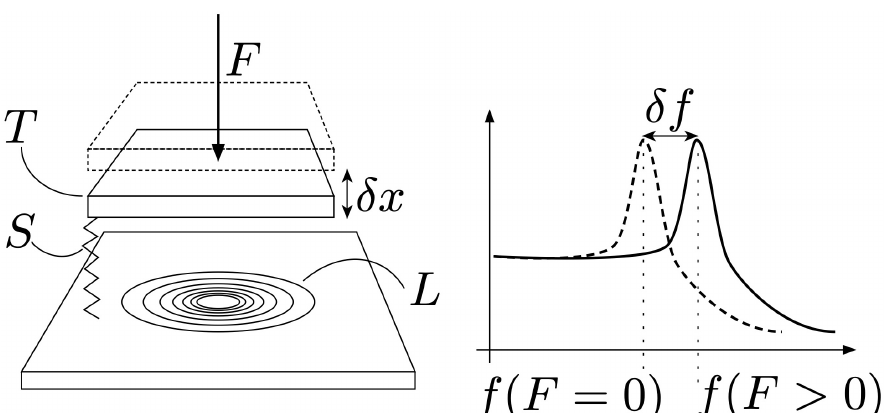
Figure 3. Load sensor working principle. By applying a force F to the target T , the spring S is gets displaced by δ x . This change in target position causes the inductance L of the LC-tank to change, and thus causes a change in resonance frequency δ f . By measuring the resonance frequency f of the LC-tank for various forces F , one can construct a mapping from f to F and thus estimate the forces based on the LC-tank’s resonance